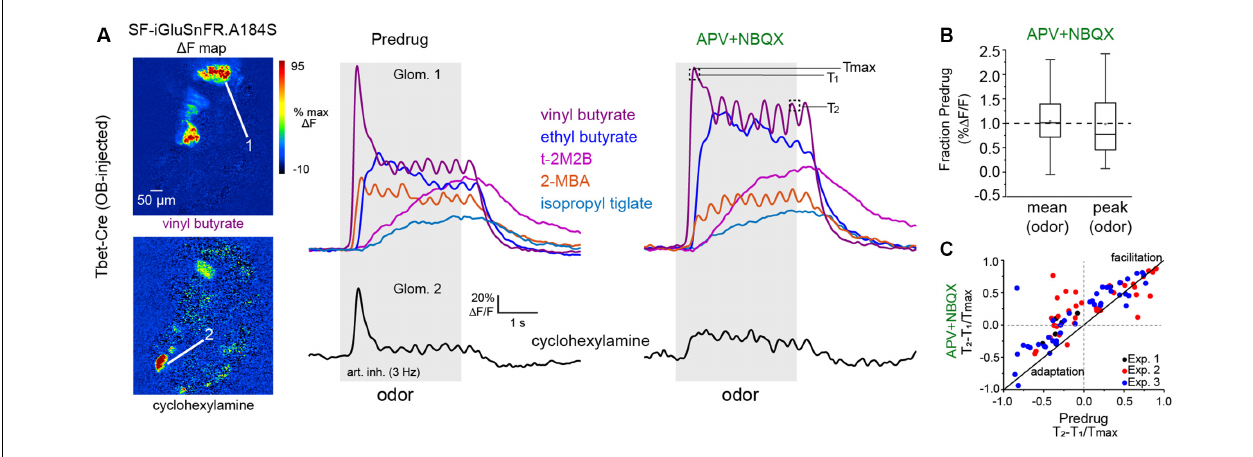
FIGURE 6 | Impact of multisynaptic excitation on slow temporal dynamics of glutamate signaling across inhalations. (A) Left: ∆ F response maps showing MT cell glutamate responses to two odorants before application of APV+NBQX (1 mM/0.5 mM). Signals are from SF-iGluSnFR.A184S injected into the OB of a Tbet-Cre mouse. Right: Traces (mean of four presentations) from two glomeruli (top, bottom) showing diverse temporal responses to different odorants, before and after APV+NBQX application. Response to cyclohexylamine (bottom) shows a loss of the initial transient and replacement by tonic signal. Response to vinyl butyrate (top) shows an increase in initial response magnitude and apparent loss of adaptation. Temporally distinct response patterns to other odorants persist after drug application. T1, T2, T max indicate time-points used to quantify slow temporal dynamics, as in (C) . (B) Box plots (as in Figure 5 ) showing no overall impact of APV+NBQX on mean and peak response amplitudes (each measured across the duration of odorant presentation) across all glomerulus-odorant pairs ( n = 83, three mice). (C) Scatter plot of T 2 − T 1 /T max values before and after APV+NBQX for all responsive glomerulus-odor pairs across three experiments (each experiment indicated by color), showing decrease in adaptation for many pairs after application of APV+NBQX. Summary statistics: Paired t-tests, Exp. 1, n = 7 glomerulus-odor pairs, p = 0.004; Exp. 2: n = 34, p = 0.004; Exp. 3: n = 42, p = 1.63 × 10 − 5